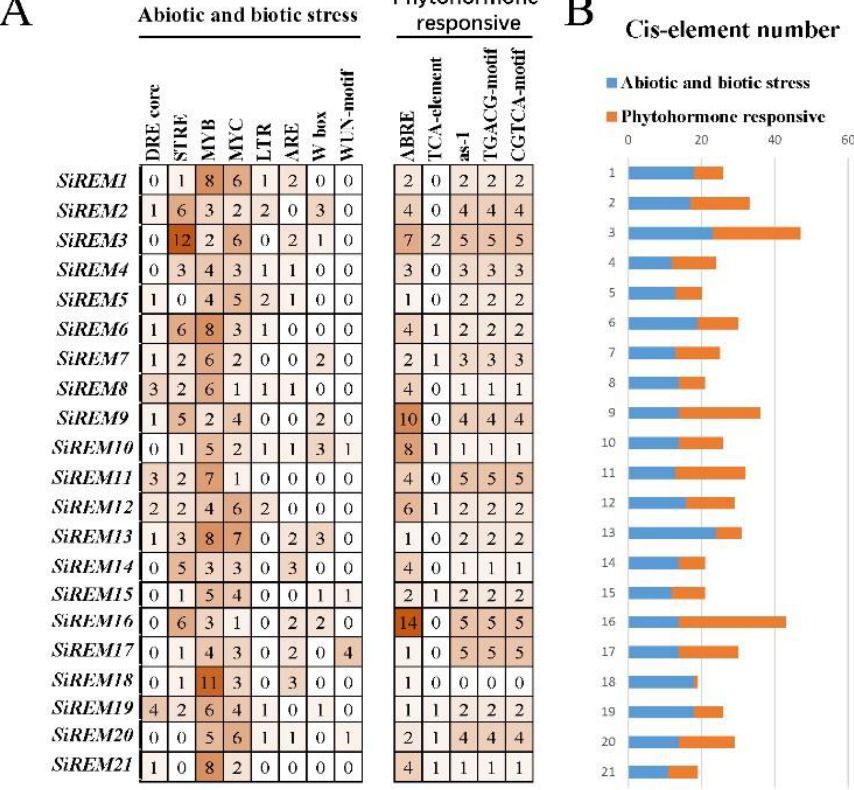
Figure 5. Cis-acting element analysis of the remorin gene family in millet. ( A ). The number of different promoter elements in the remorin genes indicated by different intensity colors and numbers. ( B ). Different colors in the histogram represent the number of cis-acting elements in two functional categories.